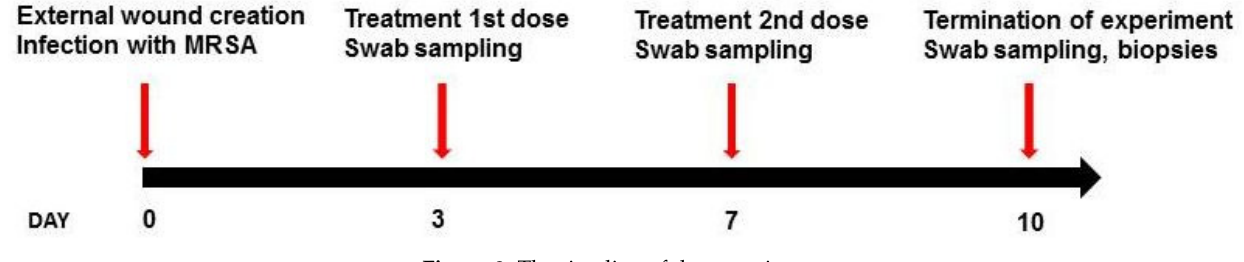
Figure 8. The timeline of the experiment.